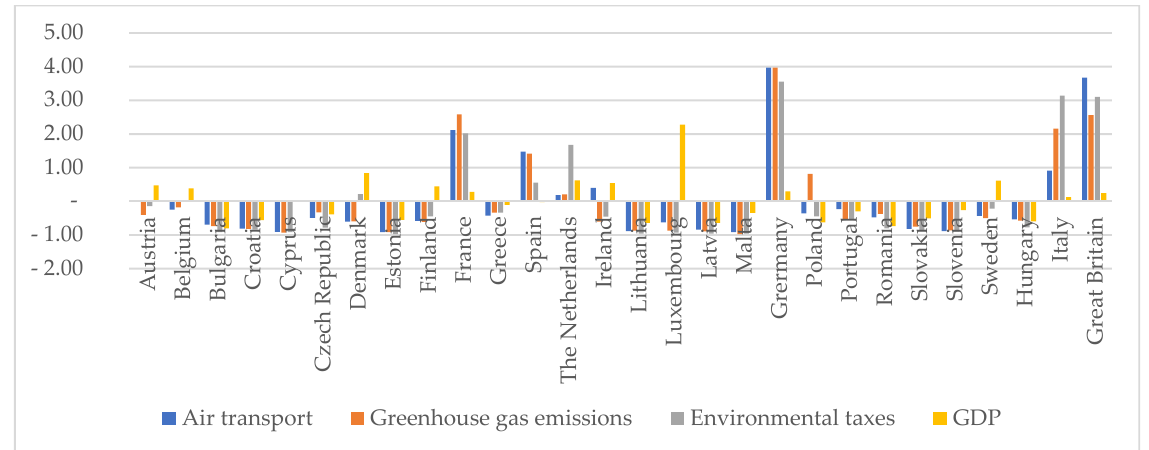
Energies 2021 , 14 , x FOR PEER REVIEW